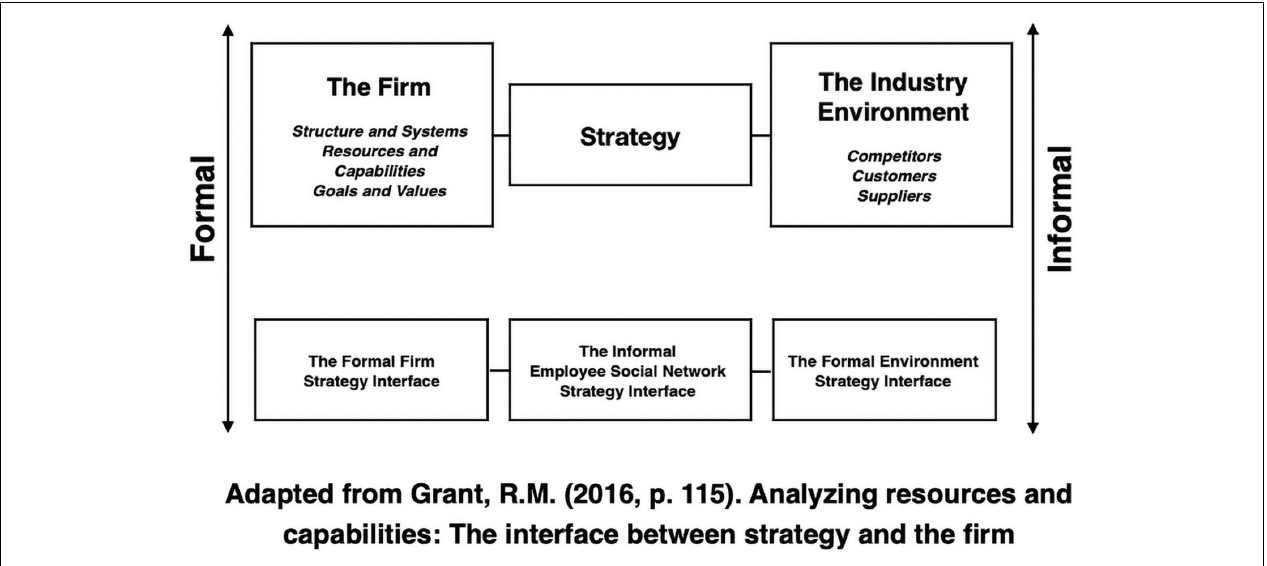
FIGURE 4 | Analyzing informal employee social networks in formal strategy